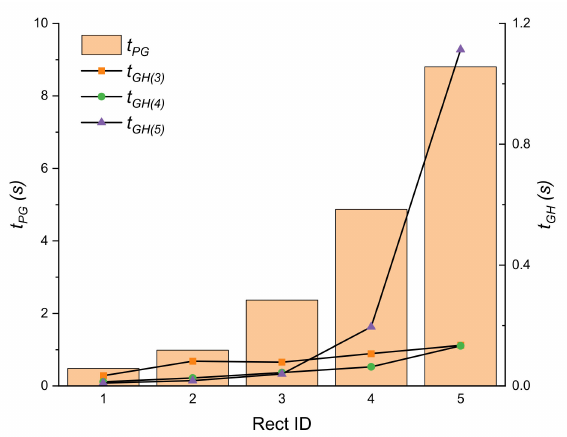
Figure 13. Comparison of the time cost associated with the geohash index ( t GH ) and PostGIS software ( t PG